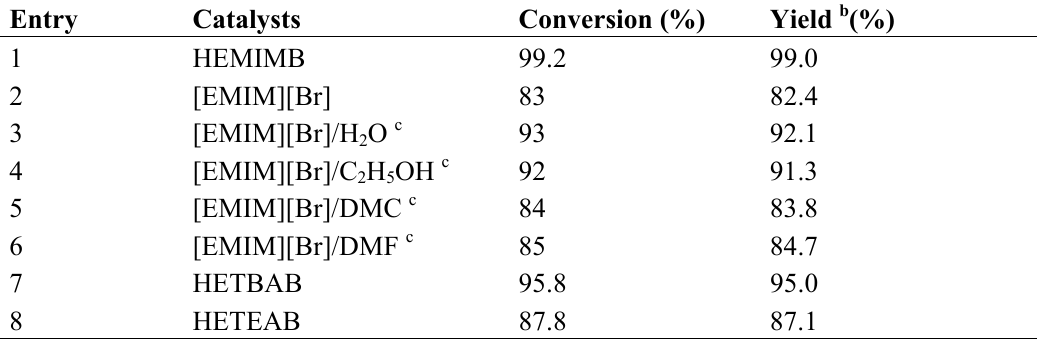
Table 6. Synthesis of PC catalyzed by Hydroxyl-functionalized ionic liquids (HFILs) catalyst a [77,78].